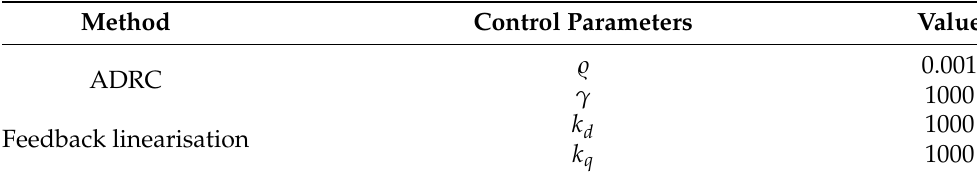
Table 2. Tuning parameters of the proposed controller.